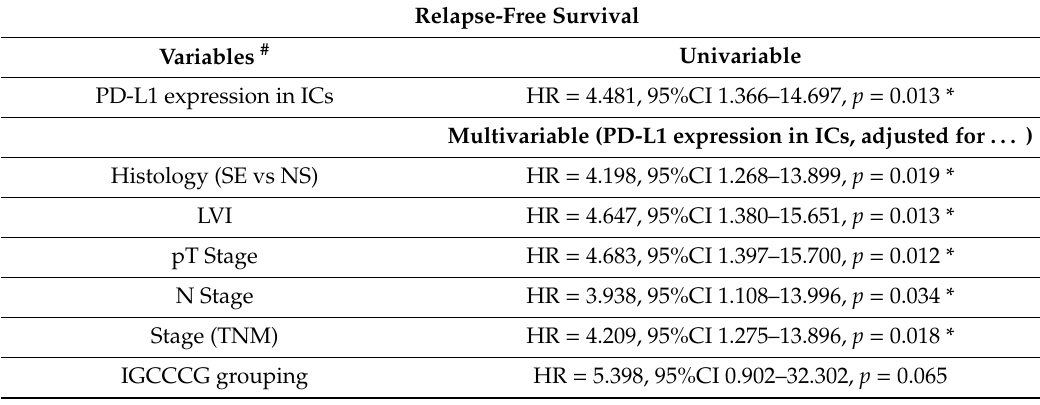
Figure 4. Relapse-free survival according to PD-L1 positivity in immune cells of testicular germ cell tumors. Abbreviations: IC—immune cells; RFS—relapse-free survival. Table 3. Survival impact of PD-L1 immunoexpression in immune cells in univariable and multivariable analyses.